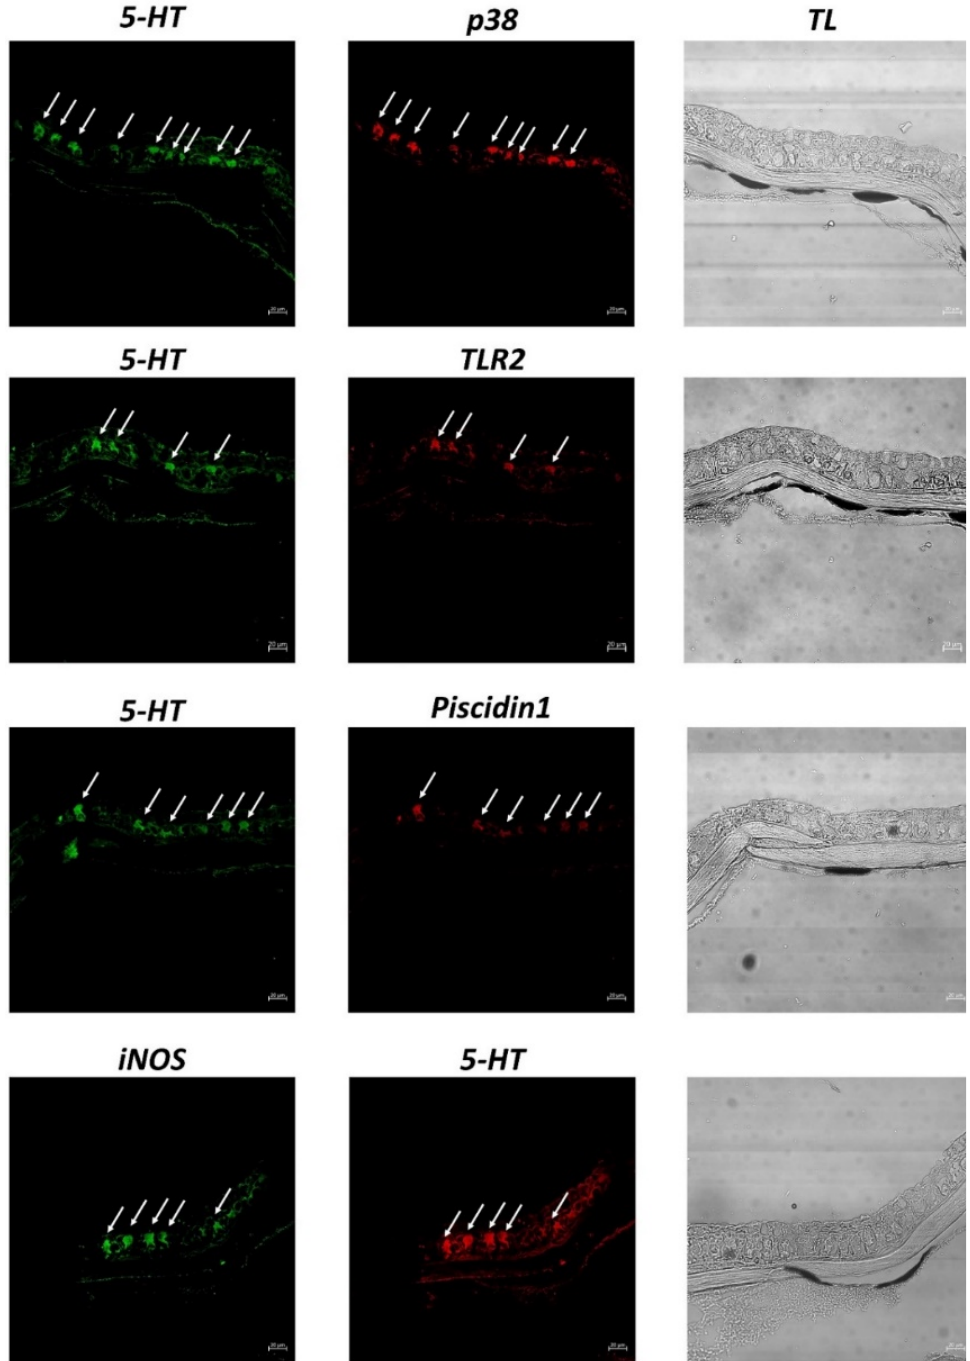
Figure 4. Cross sections (5 μ m thick) of zebrafish skin. Sections are immunohistochemically treated with MAPK p38, TLR2, Piscidin1, 5-HT, and iNOS. Immunofluorescence 20 × , scale bar 20 nm. Clear CCs immunoreactive for antibodies tested (arrows) are evident. TL= Transmitted Light.